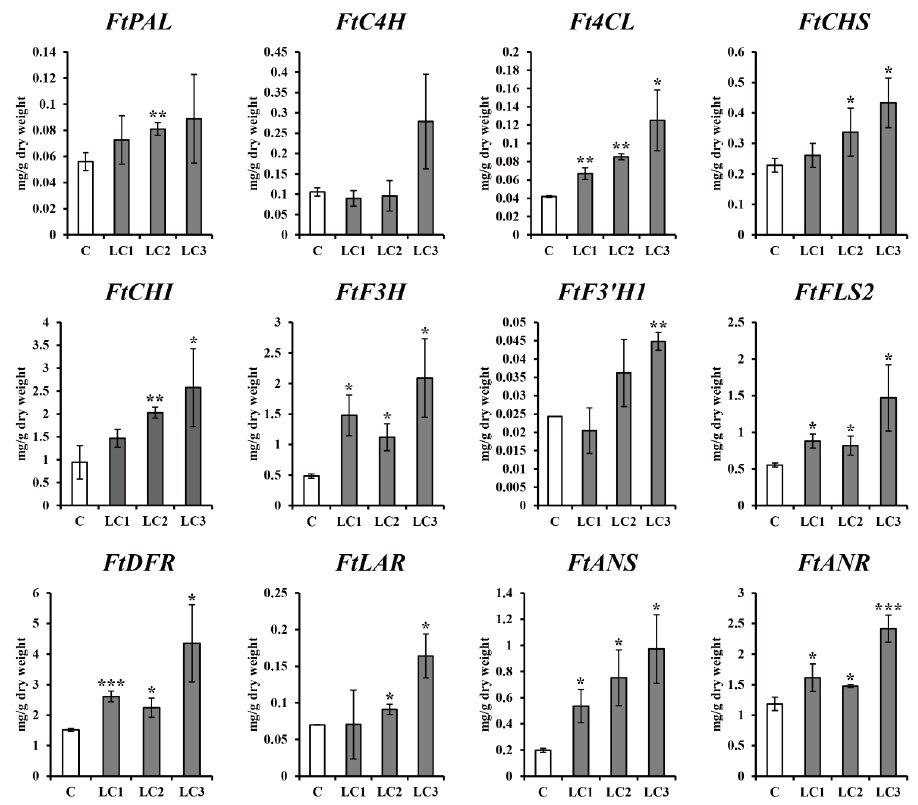
Figure 5. Effect of light treatment on the expression profiles of hairy root cultures in Fagopyrum tataricum . C: GUS-overexpressing hairy root line 1; LCn: ZmLc-overexpressing hairy root lines. Asterisks represent statistical significance (* p < 0.05; ** p < 0.01; *** p < 0.001).